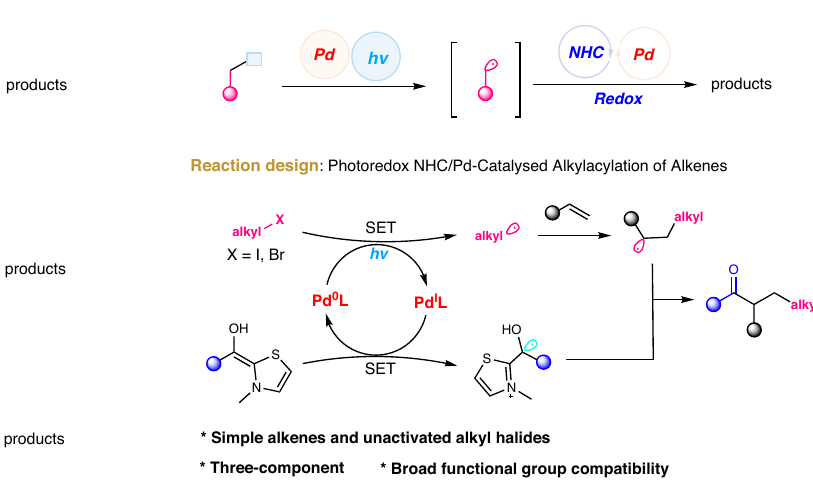
Fig. 1 | Redox NHC and cooperative NHC/TM catalysis. a Redox NHC-catalyzed radical reactions. b The merging of photoredox and NHC catalysis. c The combi- nation of NHC with TM catalysis. d Our strategy: photoredox cooperative NHC/